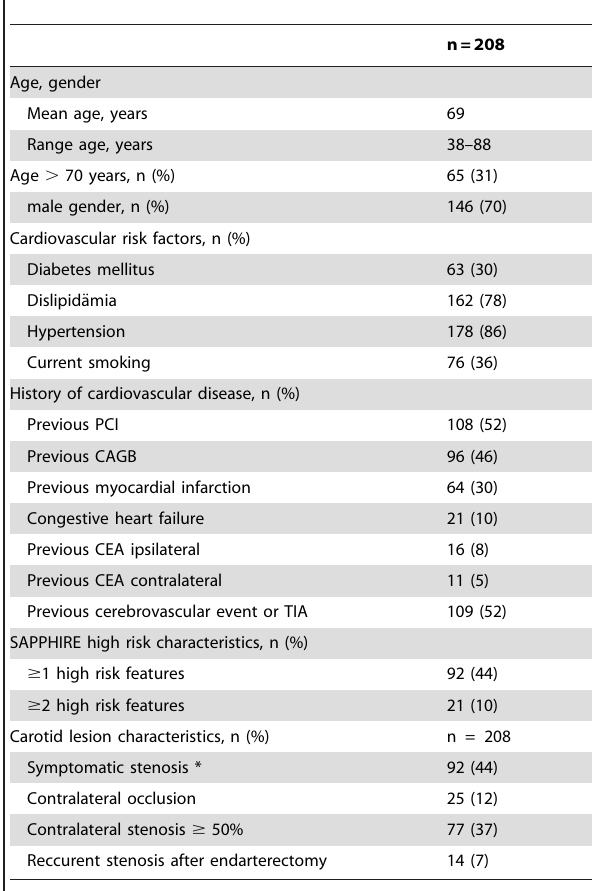
Table 1. Baseline Characteristics.